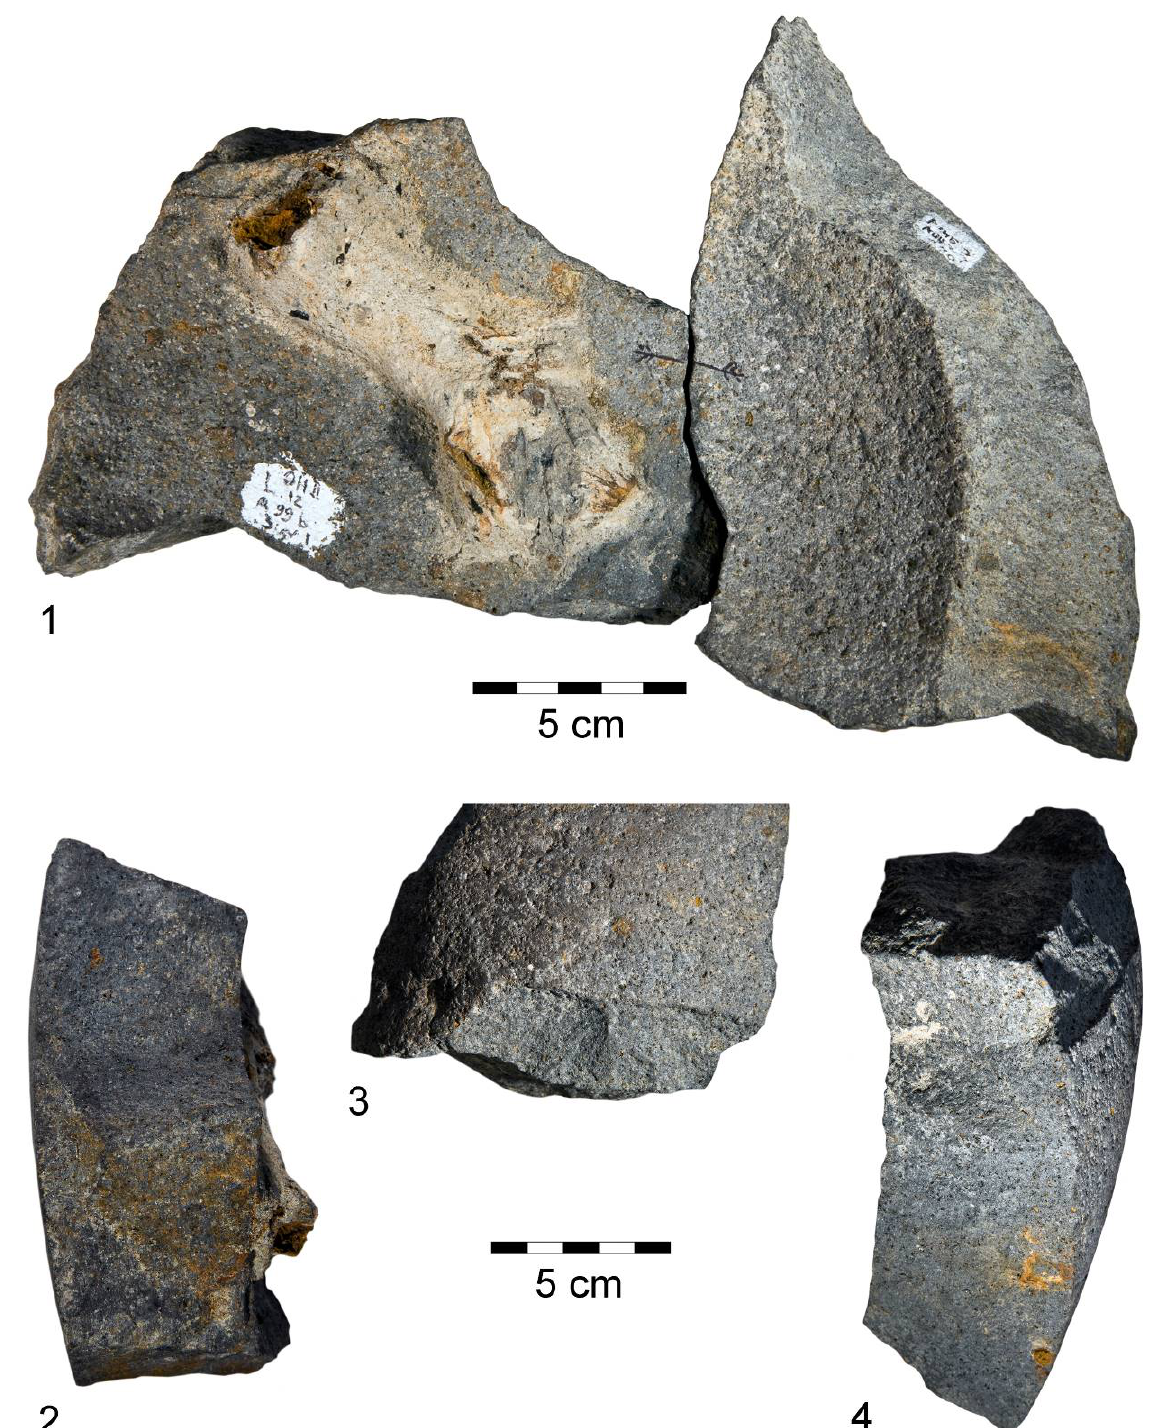
Figure 7. Two refitted fragments of a basalt bowl, Loc. 12. 1) top view, note the incrustation on the left fragment; 2, 4) the profiles of the two specimens; 3) two flaking scars on the edge of a